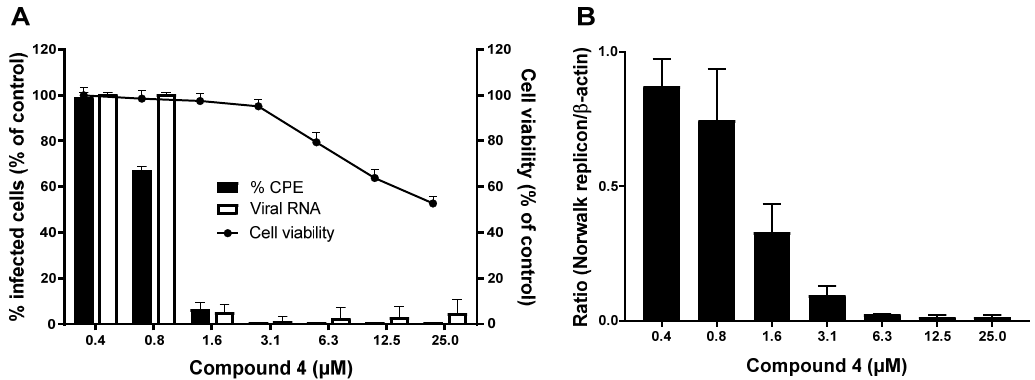
Figure 1. The antiviral effect of compound 4 against MNV and the HuNoV GI.1 replicon. ( A ) The antiviral activity of compound 4 against MNV was quantified by (i) virus-induced CPE reduction and (ii) reduction in viral RNA levels. Cellular toxicity was assessed in parallel. n = 3–4 ( ± SEM). ( B ) The antiviral activity of compound 4 against the HuNoV GI.1 replicon. Intracellular RNA loads are represented by relative genome quantification of the HuNoV GI.1 replicon versus β -actin. n = 5 ( ± SEM).